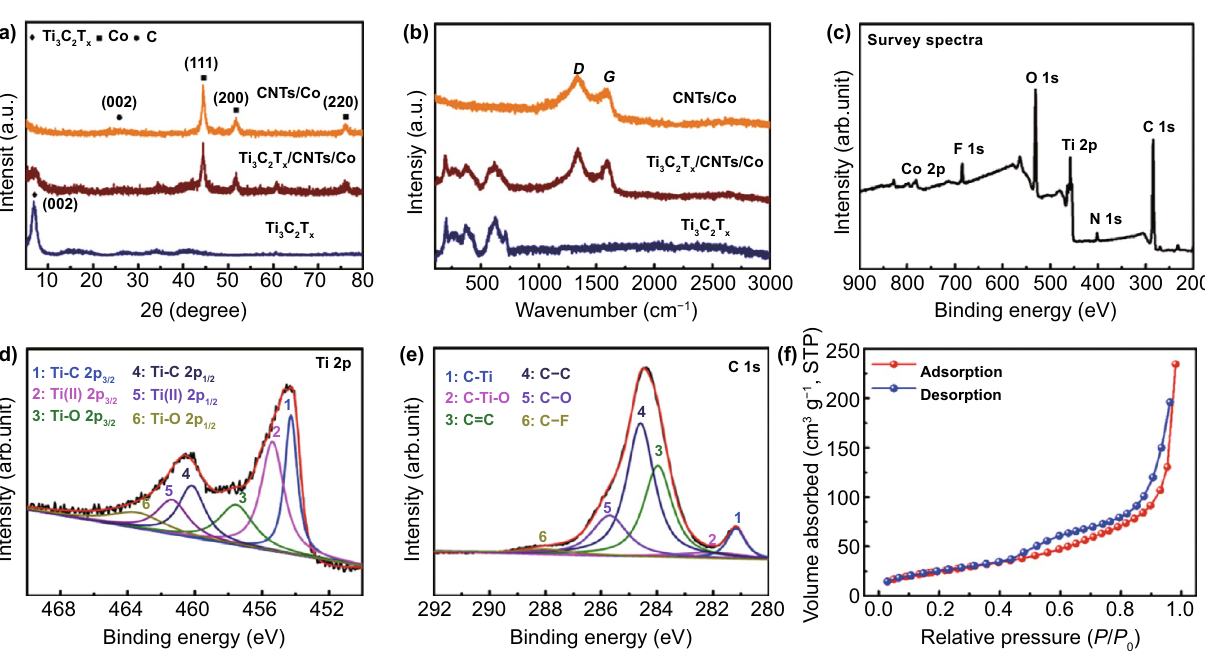
Fig. 1 XRD curves ( a ) and Raman spectra ( b ) of Ti 3 C 2 T x , Ti 3 C 2 T x /CNTs/Co, and CNTs/Co nanocomposites. XPS survey spectra ( c ), Ti 2p XPS spectrum ( d ), C 1 s XPS spectrum ( e ), and N 2 adsorption–desorption isotherms ( f ) of Ti 3 C 2 T x /CNTs/Co